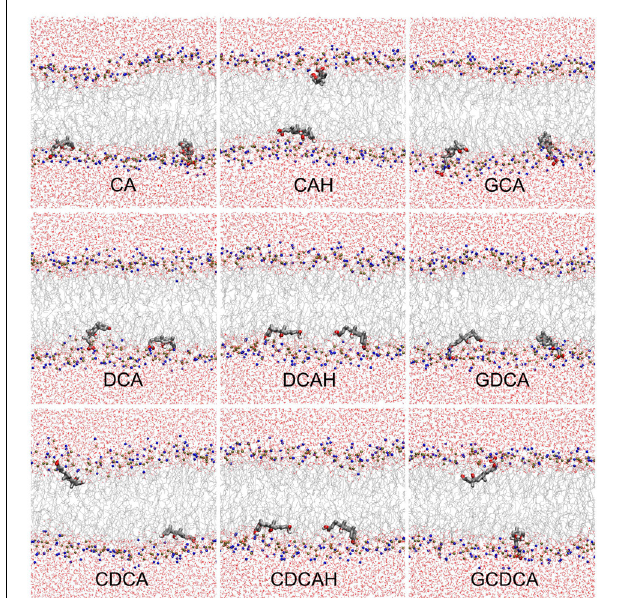
FIGURE 2 | Final snapshots of the simulations with initial BS location in the center of the bilayer. BS molecules are depicted in licorice, while POPC and water molecules are depicted in line style. Atom colors are gray, red, brown, blue, and white, for C, O, P, N, and H,